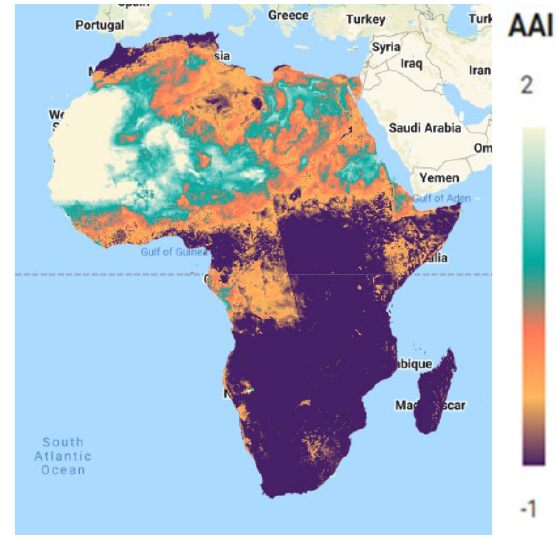
Fig. 6. Aerosol movement from the 16 th – 18 th of June 2020 However, from the 10 th composite (Fig 7), there was a significant decrease in the size of the dust plume as it moved into the Atlantic Ocean This serves as a rich source of phosphorus and iron to phytoplankton, and other plant species in the ocean (Zaigham et al., 2021).